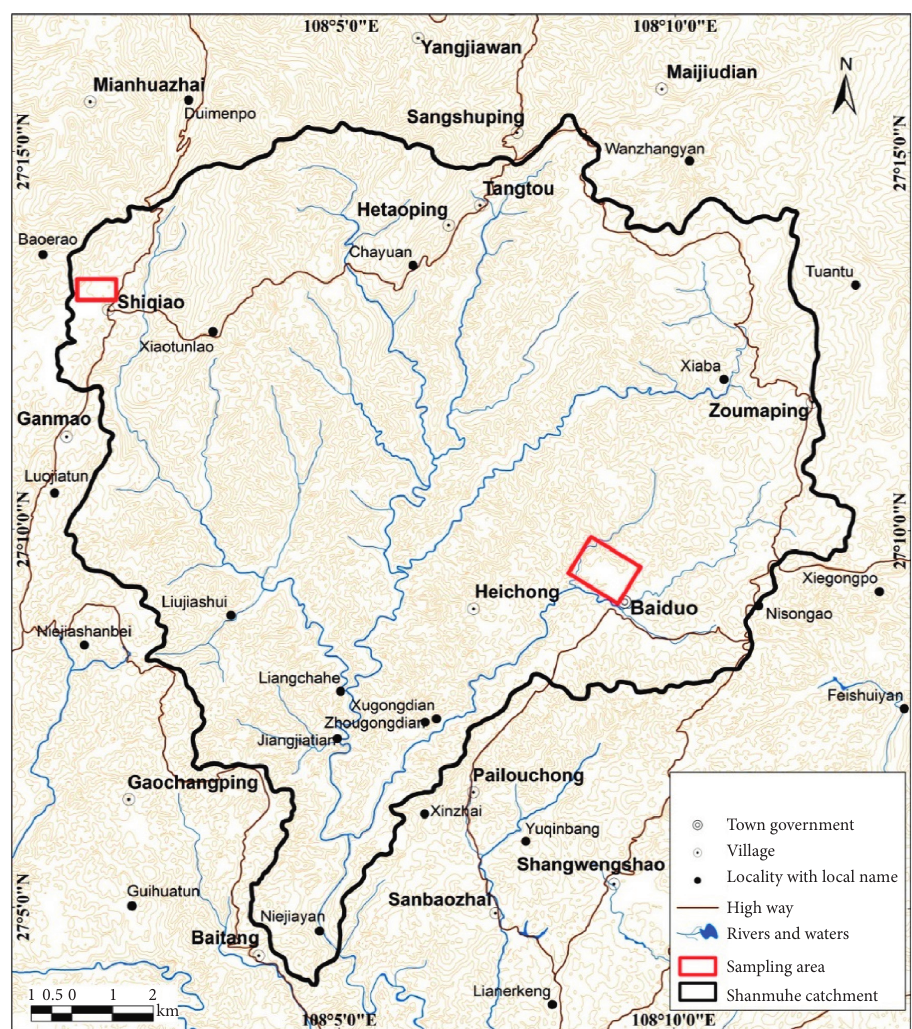
Figure 2: Location of the Shanmuhe catchment and sampling Table 1: Characteristics of each sampling site.